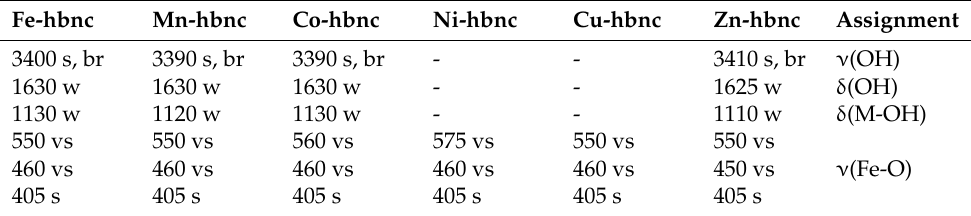
Table 1. Absorption maxima (cm − 1 ) in the IR spectra of samples. Fe-hbnc Mn-hbnc Co-hbnc Ni-hbnc Cu-hbnc Zn-hbnc Assignment 3400 s, br 3390 s, br 3390 s, br - - 3410 s, br ν (OH) 1630 w 1630 w 1630 w - - 1625 w δ (OH) 1130 w 1120 w 1130 w - - 1110 w δ (M-OH) 550 vs 550 vs 560 vs 575 vs 550 vs 550 vs ν (Fe-O)460 vs 460 vs 460 vs 460 vs 460 vs 450 vs 405